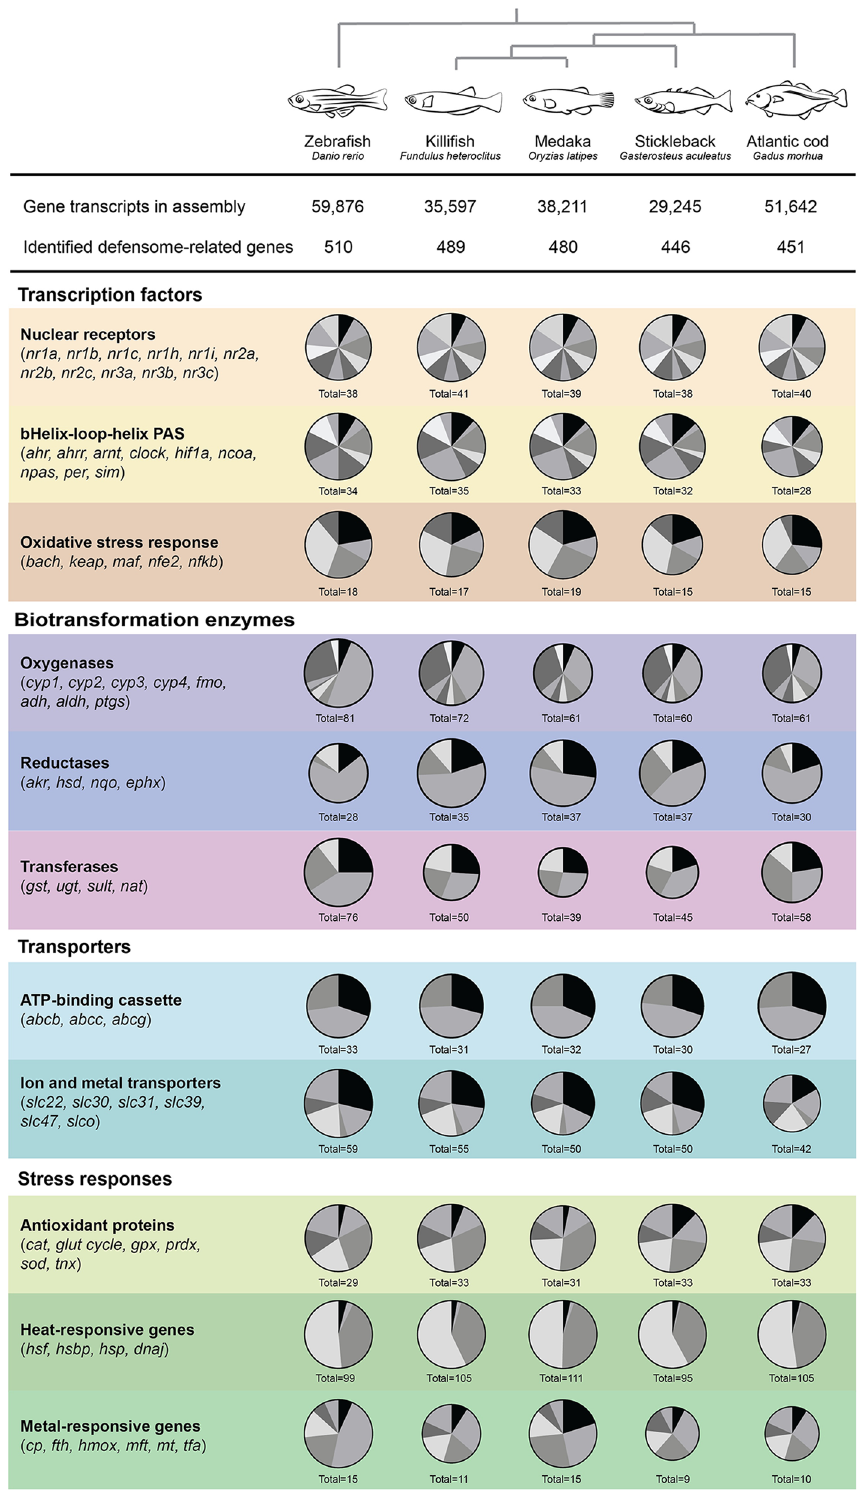
Figure 1. Chemical defensome genes in five model fish species. The genes were identified by searching gene names and using HMMER searches with Pfam profiles, followed by reciprocal or best-hit blast searches towards the zebrafish proteome. The gene families are organized in categories following Gene Ontology annotations and grouped by their role in the chemical defensome. The size of the disk represents the relative number of genes in the different fish genomes within each group, with the number of genes in a specific gene family as